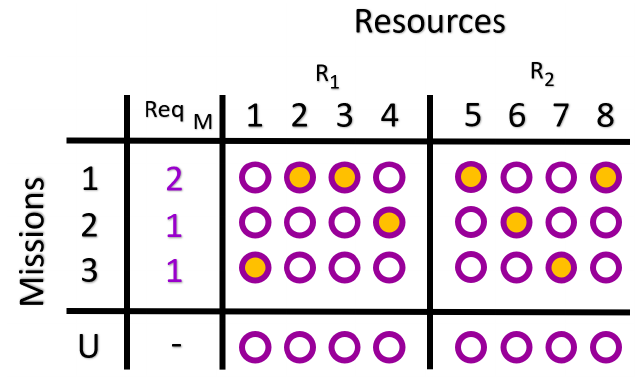
Figure 2. Matrix view for Solution. This solution is shown for a problem with three missions, four resources of type R 1 and four resources of type R 2 . REQ M describes how many R 1 resources must be assigned to mission m . Each R 1 resource is paired with exactly one R 2 resource for each